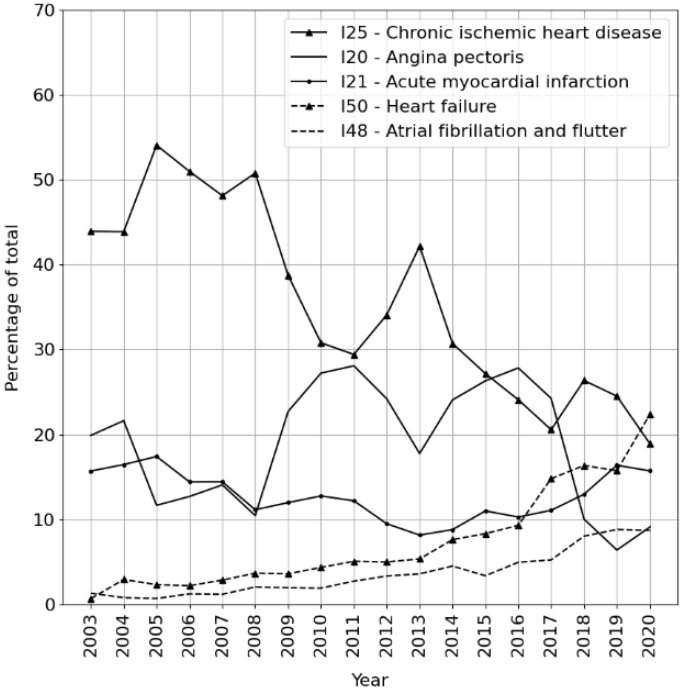
Figure 2. Development of the proportions of 5 most frequent primary diagnoses in the dataset be- tween 2003 and 2020. between 2003 and